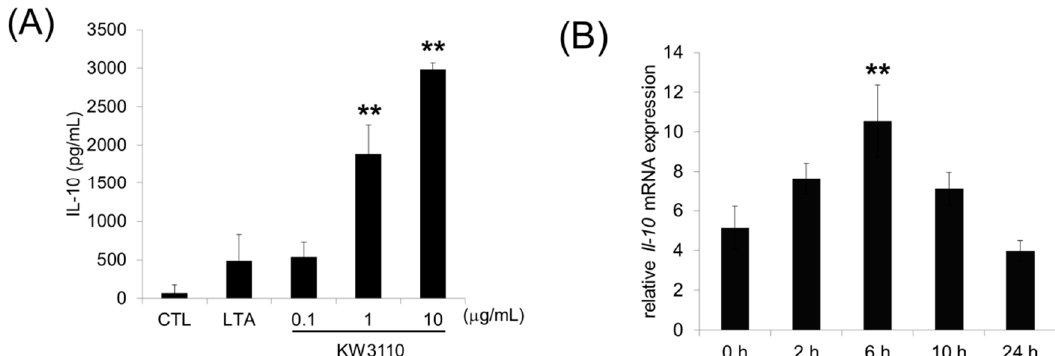
Figure 1. Effects of L. paracasei KW3110 on the activation of M2 macrophages and induction of IL-10 production. ( A ) Bone marrow-derived M2 macrophages were stimulated with lipo-teichoic acid (10 ng/mL), and L. paracasei KW3110 (0.1, 1, or 10 µg/mL) and the amounts of secreted IL-10 were measured by ELISA. ( B ) Relative IL-10 mRNA expression was measured using PCR. Values are represented as the mean ± SEM. Significance was assumed if the p value was < 0.05. ** p < 0.01. LTA, lipo-teichoic acid treated group; CTL, control; KW3110, L. paracasei KW3110 treated group.